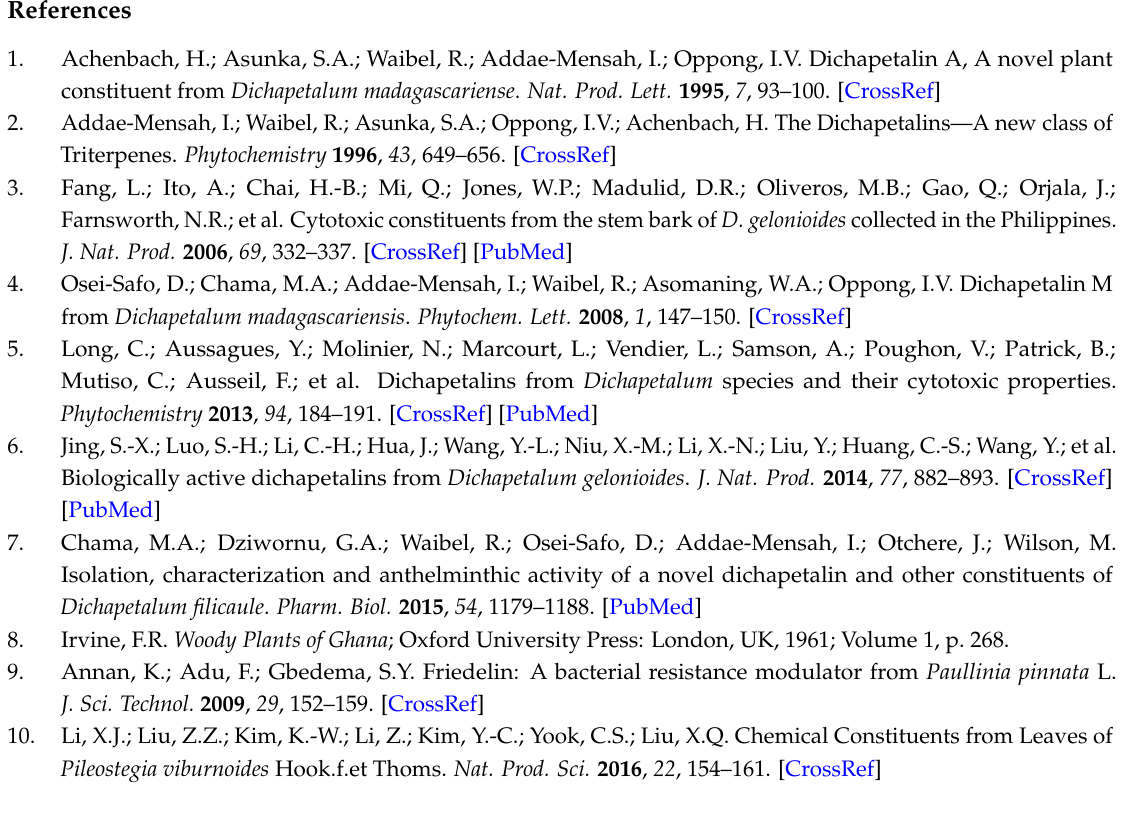
Figure S1: The structures of compounds 1 – 8 , Figures S2–S11: Spectroscopic data for compounds 1 – 3 , Tables S1–S3: Biodata for compounds 1 – 3